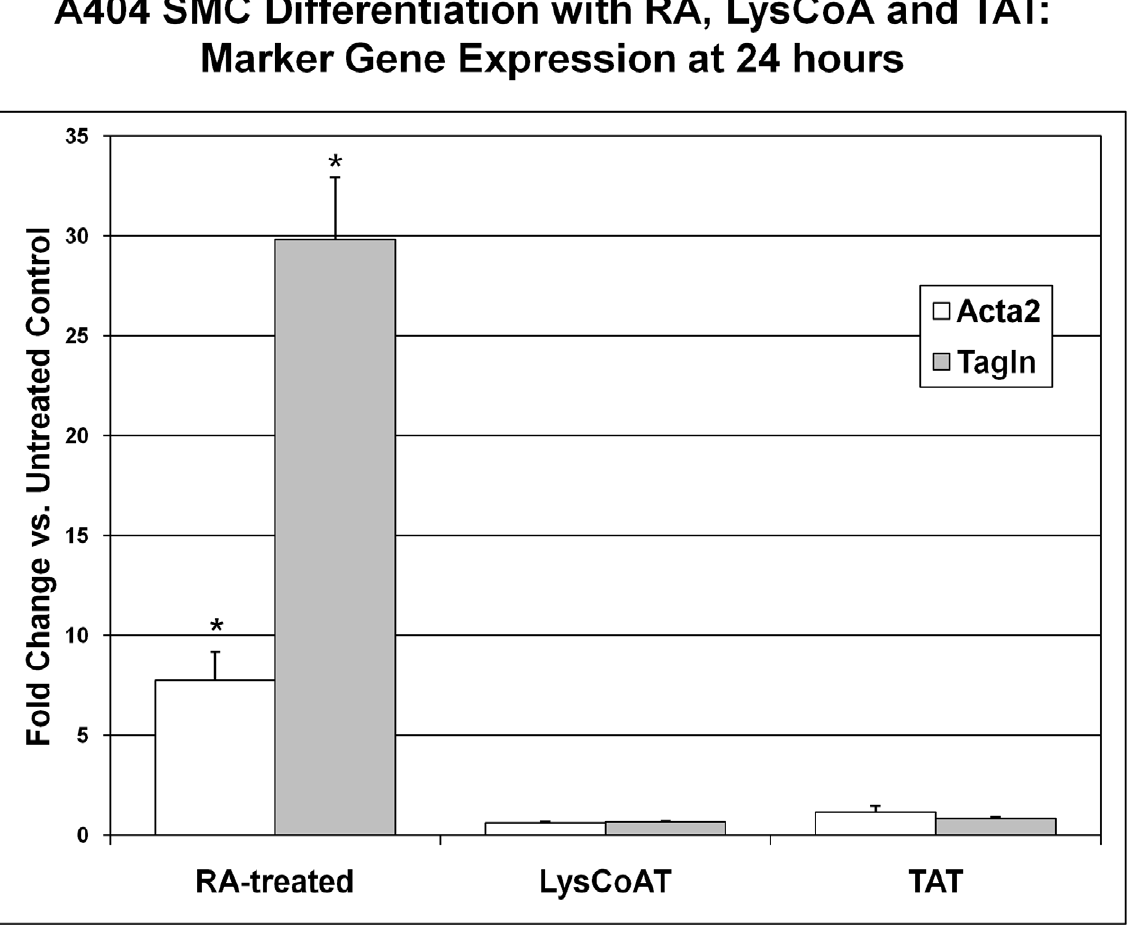
Figure 7. p300 HAT inhibition controls. A404 cells were treated for 24 hours with: 1) retinoic acid (RA), 2) 20 m M Lys-CoA-TAT (LysCoAT), or 3) 20 m M control TAT peptide (TAT). Expression levels obtained by qRT-PCR for SMC markers are shown as fold change from baseline untreated cells 6 standard error. * = significantly (p , 0.05) different from control.